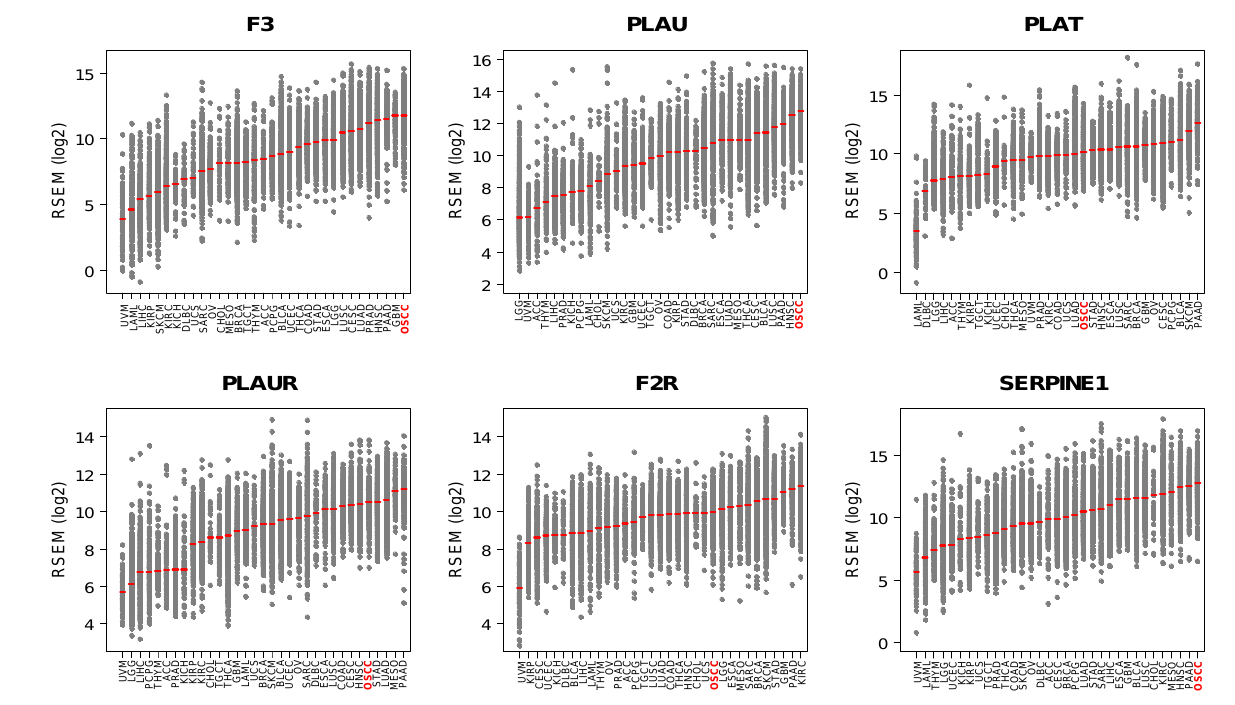
Figure 1. Coagulome gene expression in human tumors. Dot plots showing the tumor type ranking according to the mRNA expression levels of six essential components of the tumor coagulome ( F3 , PLAU , PLAT , PLAUR , F2R and SERPINE1 ). Data from n = 33 tumor types, including OSCC, were retrieved from TCGA (total number of tumors analyzed was n = 10,071). Note that OSCC is the tumor type that presents the highest expression levels of F3 , PLAU and SERPINE1 (OSCC in red).